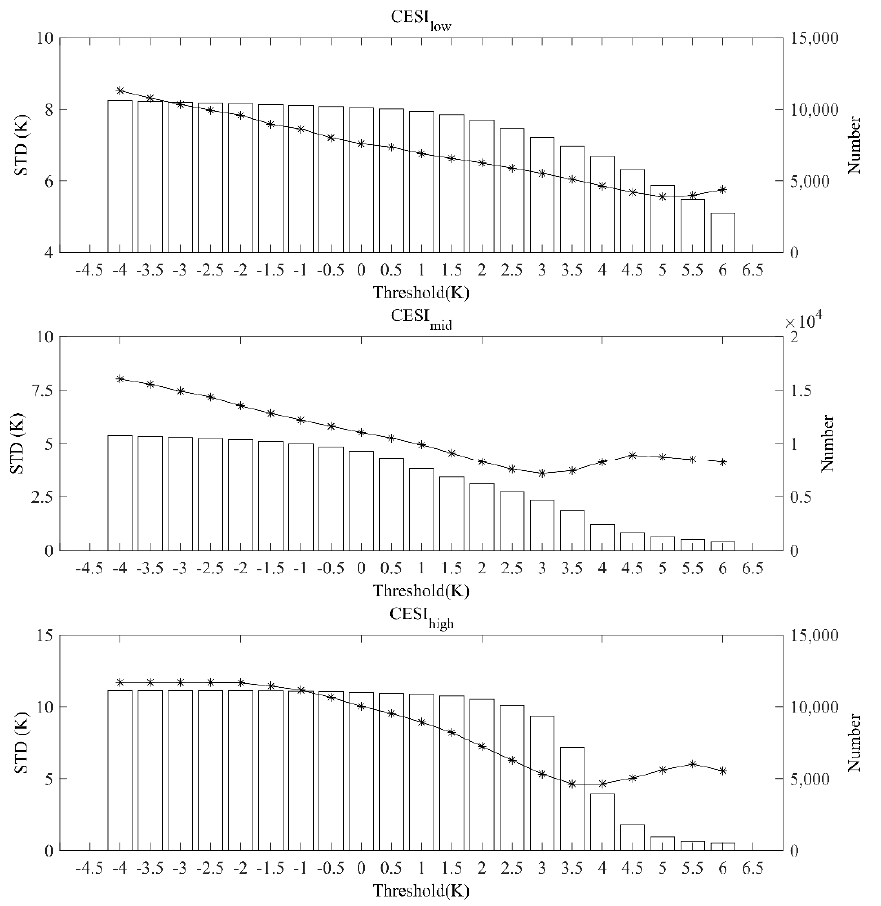
Figure 15. Same as Figure 14 except for the land surface.